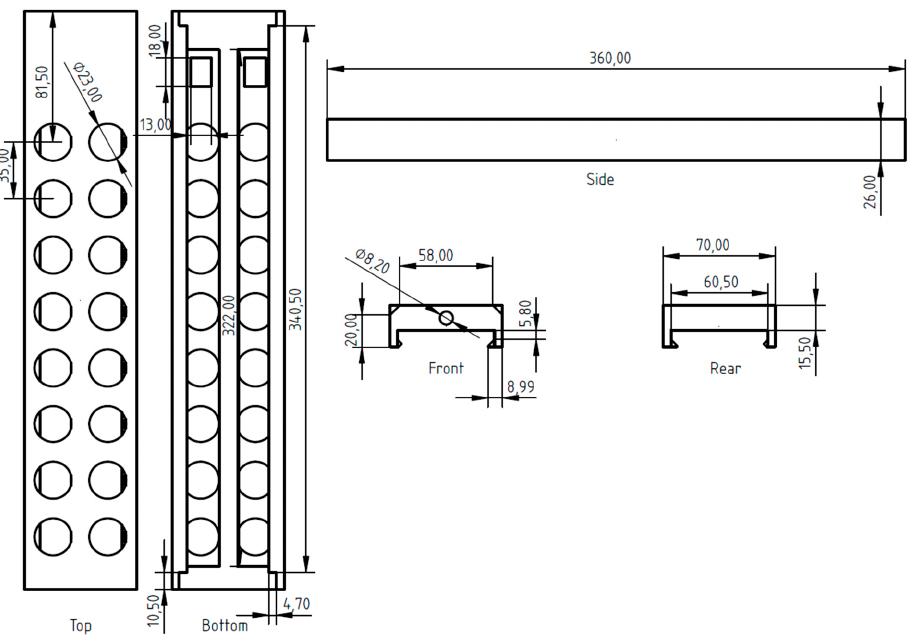
Figure A2. Technical drawing of the illumination module housing. Dimensions in mm. A comma is used as decimal separator in this figure.